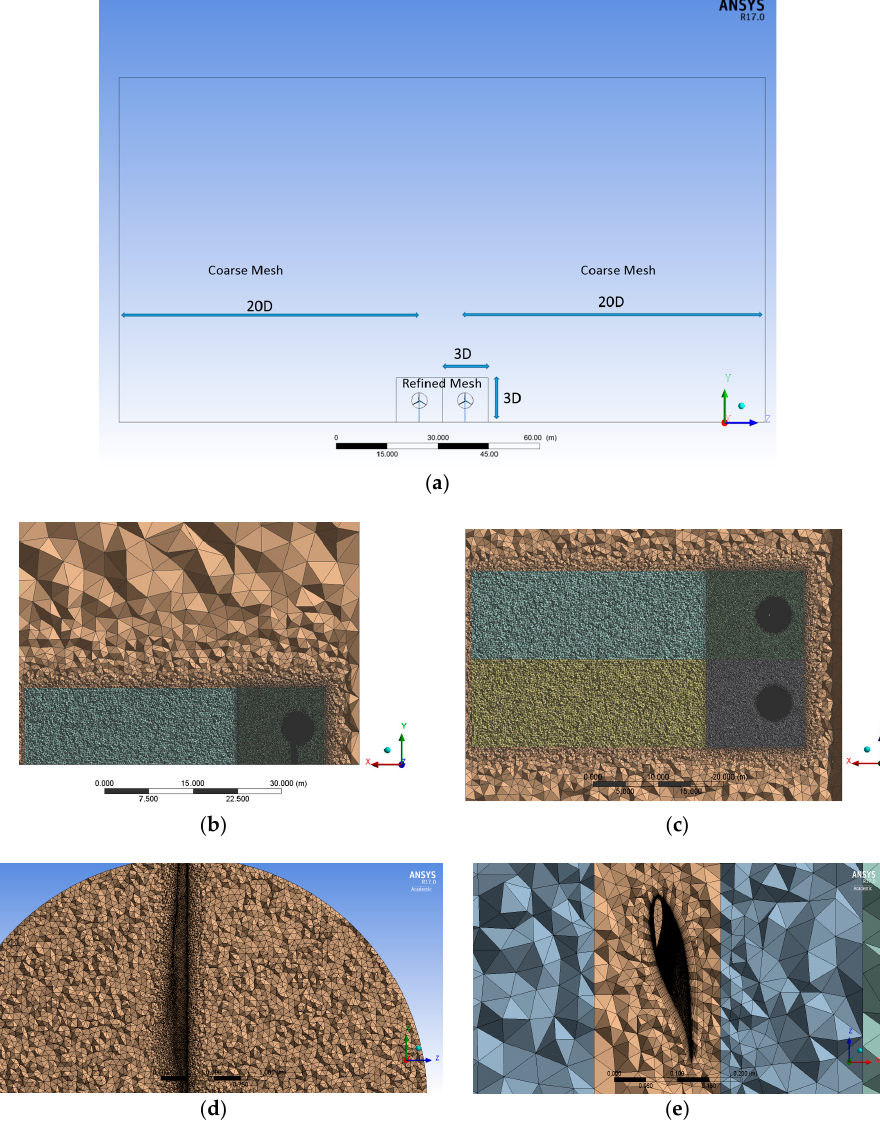
Figure 2. ( a ) Details of the meshing process for the physical domain; ( b ) lateral view of the mesh showing internal details of the sphere of influence; ( c ) top view of the mesh showing internal details of the sphere of influence; ( d ) sectional plane showing details of the mesh on the blade surface; and ( e ) details of the mesh close to the blade surface, showing inflation layers.